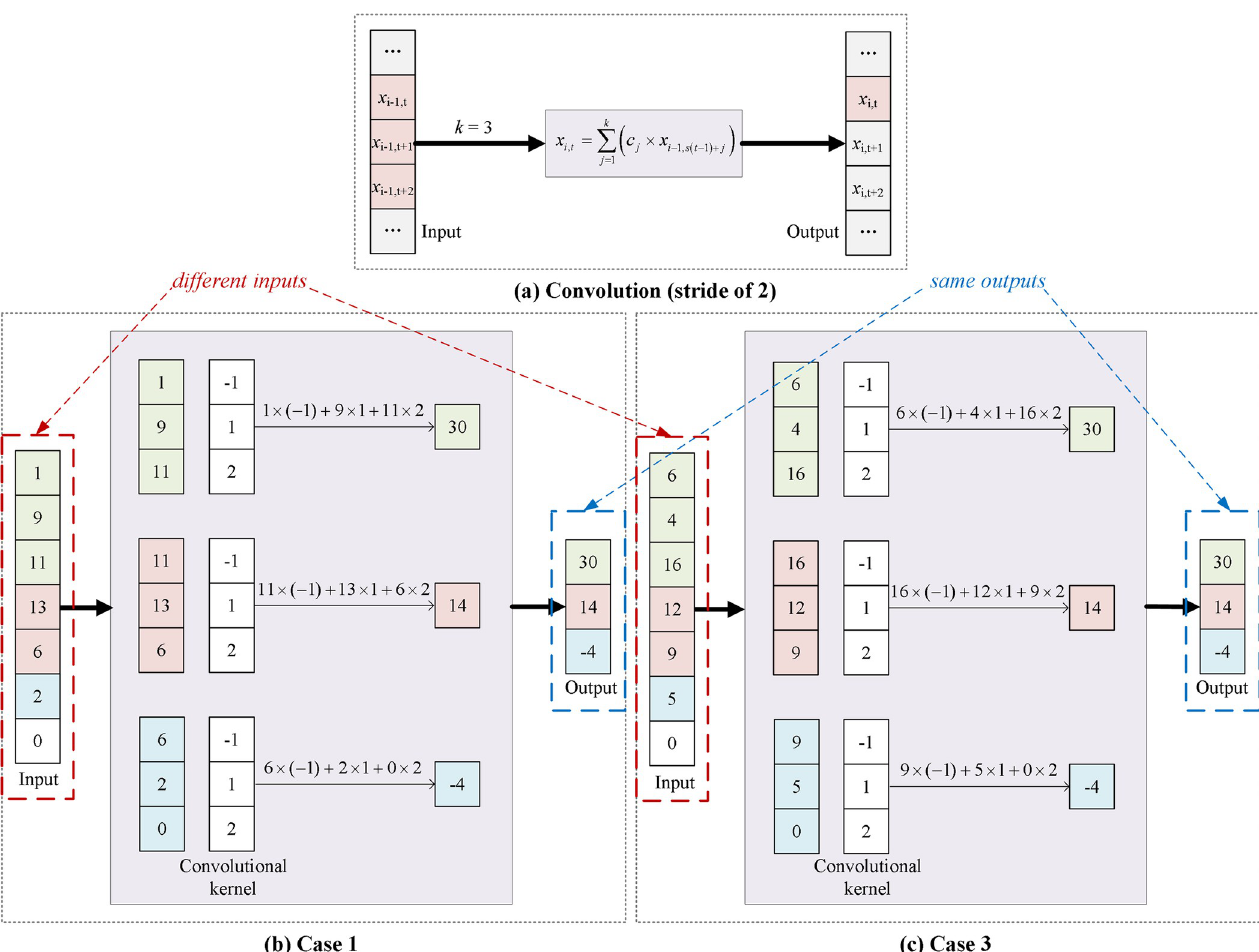
Fig 2. The procedure of the convolutional layer. (a) The feature-mixing operation of the convolution. x is the input feature, y is the output feature, and c is the element in the convolutional kernel. The kernel size is k ( k = 3) and stride is s . (b, c) Examples of the information confusion caused by the feature mixing operation of the convolution. With the same convolutional kernels, same outputs can be received even though the input data are completely different in Case 1 and 3.